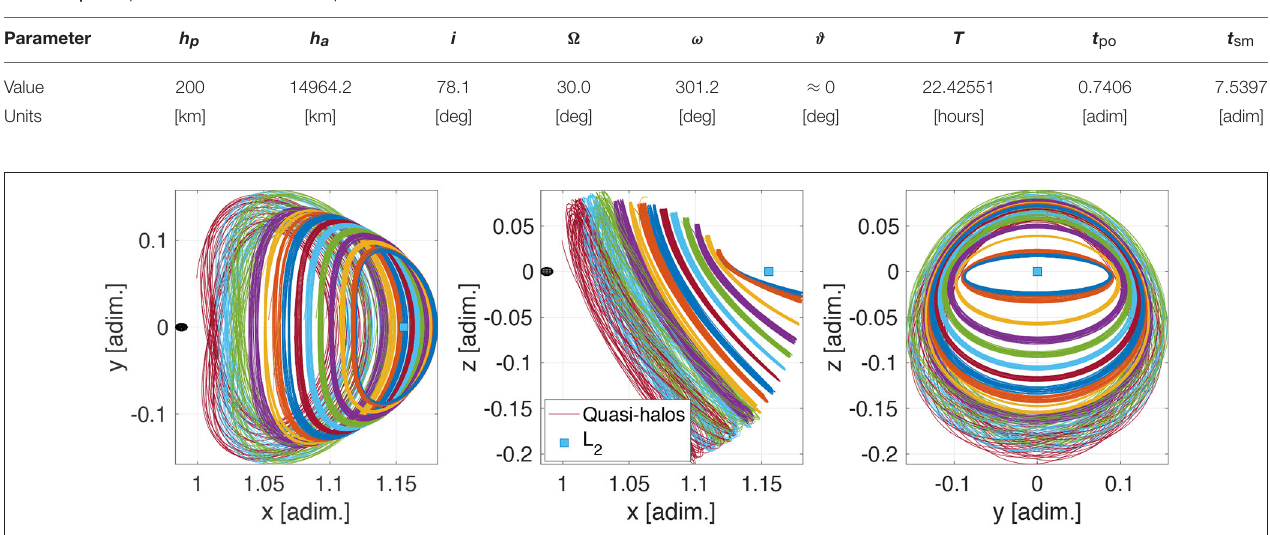
FIGURE 6 | Projection of Earth–Moon L 2 quasi-halos in the roto-pulsating frame. (adim. stands for nondimensional variable).